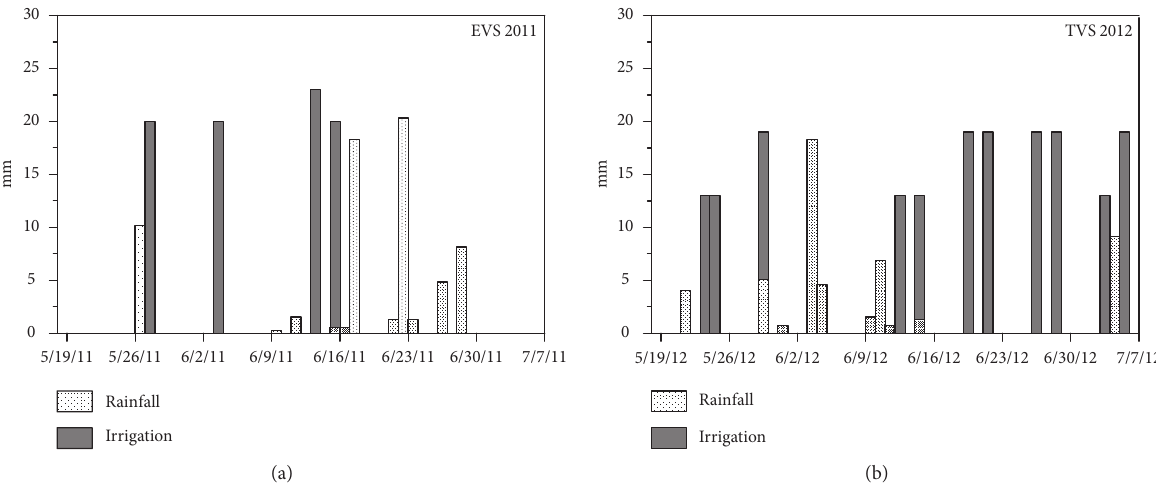
Figure 1: Rainfall and irrigation received at the low-moisture environments of EVS in 2011 (a) and TVS in 2012 (b) from May 19 to July 7 of each growing season that corresponds to the corn silking time period for all five site-years during the 2011 to 2014 growing seasons across northern and central